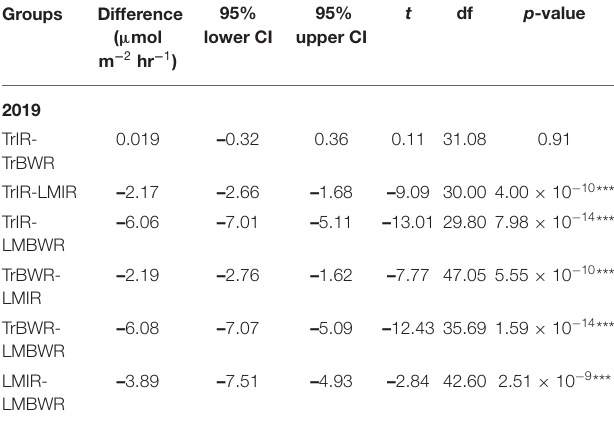
TABLE 6 | Mean CO 2 flux Welch t -test ( n = 200) between select two measurements in 2019.